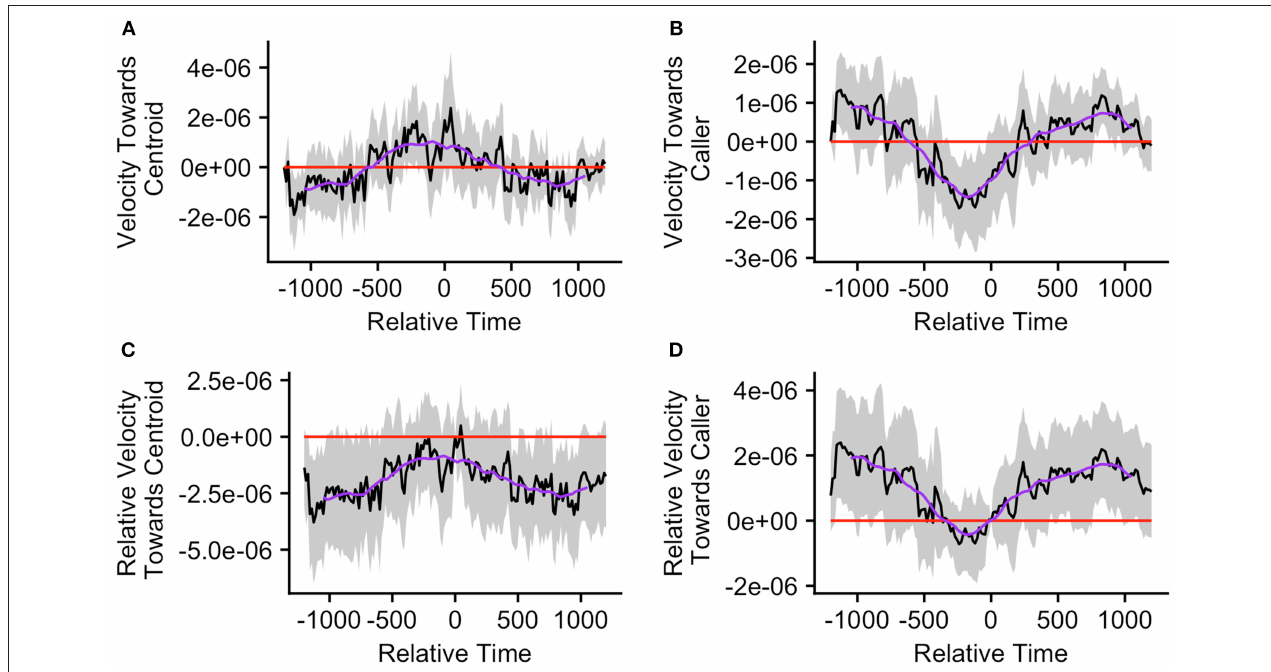
FIGURE 5 | The upper graphs show the mean velocity with 95% confidence interval of the (A) caller toward the group centroid and (B) group centroid toward the caller, from 20min before to 20min after the production of the first call (relative time = 0) in a call bout ( n = 33 calling bouts). The lower graphs show the mean difference in velocity (with 95% confidence interval) of the (C) caller toward the group centroid and (D) group centroid toward the caller compared to their own velocities at the time of the call (relative time = 0). The purple line represents the simple moving average of each plotted velocity calculated with a window of 301s centered on each datapoint.